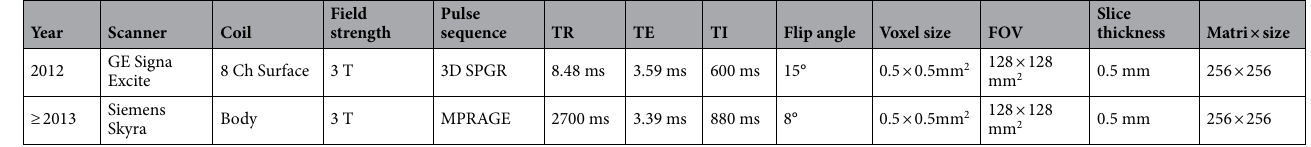
Table 1. Imaging parameters for T1-anatomical images over different